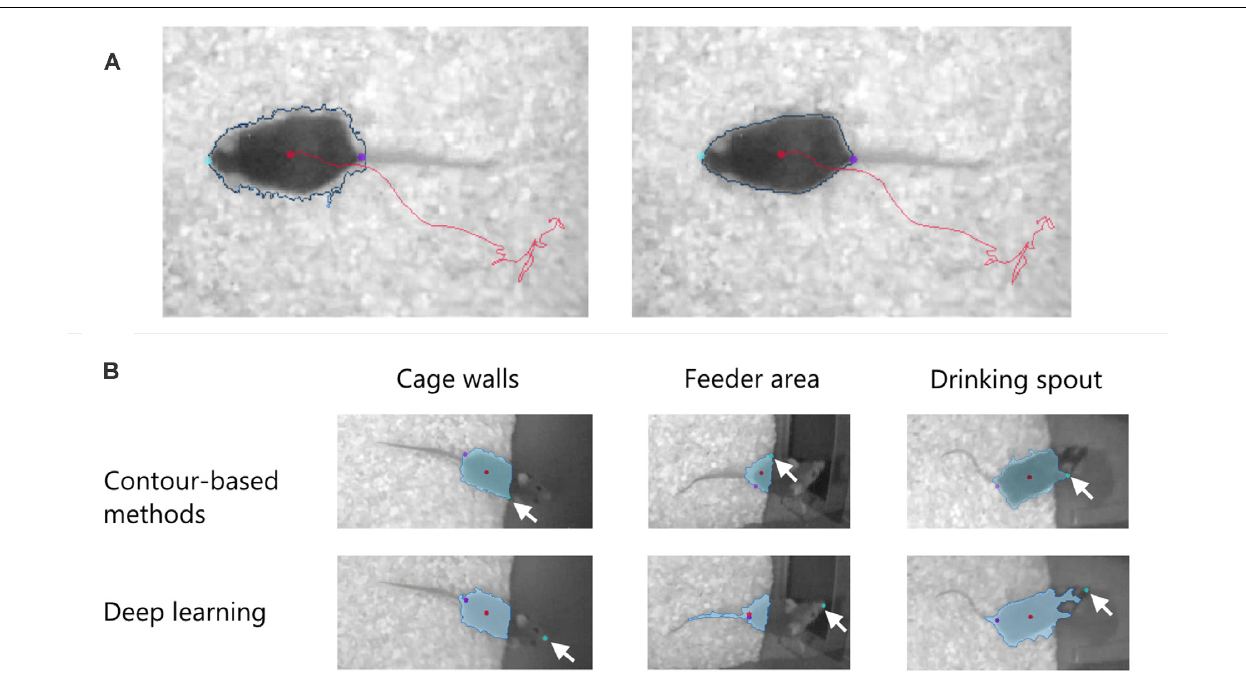
FIGURE 3 | (A) Effect of pixel filtering to remove indentations in the subject contour (blue line) and make it less dependent on the spatial variation of the background. Left: before filtering. Right: after filtering. The nose, the tail-base, and the center of the body are shown with color dots. (B) Detection of the nose point in EthoVision XT 16 in three “difficult” cases where the mouse moves over dark surfaces in a PhenoTyper cage. Two methods are used to find the nose: contour-based and deep learning. The arrows indicate the position of the detected nose. In all cases, the deep learning method correctly finds the nose independent of the detected blob (in light